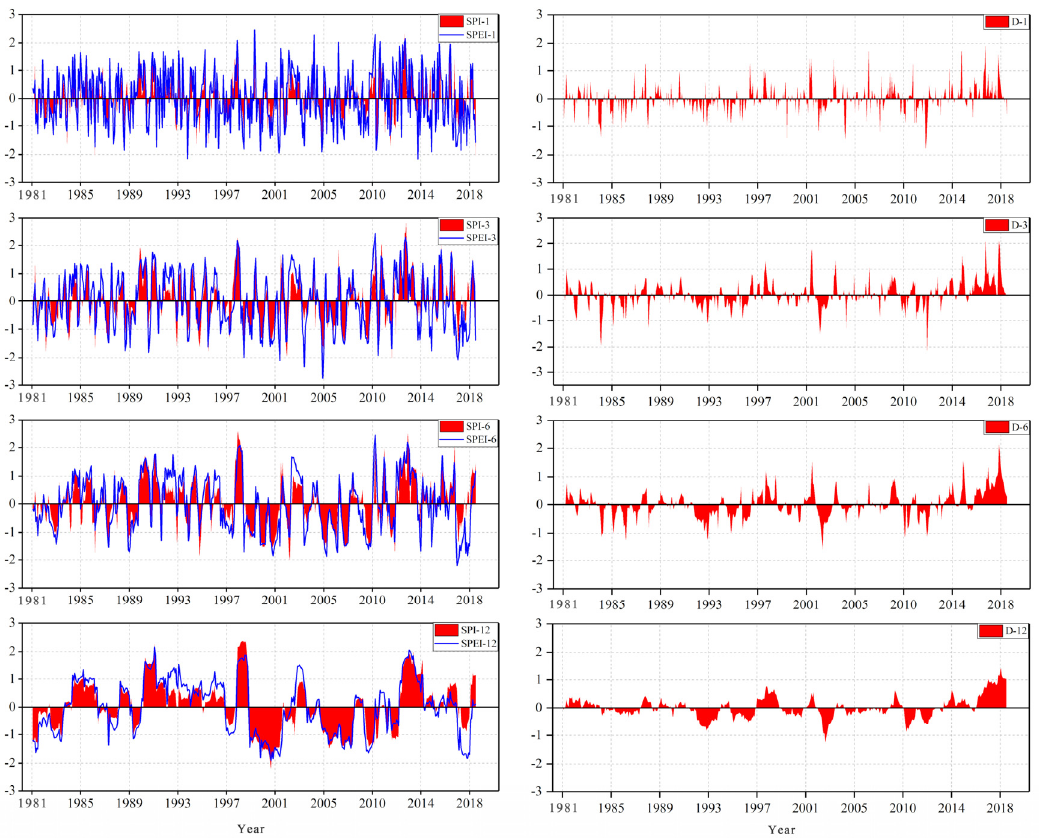
Figure 2. The temporal evolution ( left ) and the difference ( right ) of the standardized precipitation index (SPI) and standardized precipitation evapotranspiration index (SPEI) at 1-, 3-, 6-, and 12-month timescales in Inner Mongolia during 1981–2018.